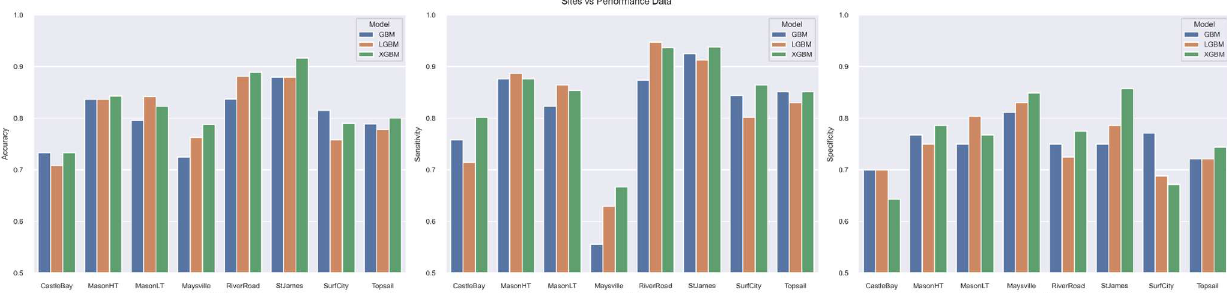
Figure 3. Performance metrics (Accuracy, Sensitivity, and Specificity in the order from left to right) of GBM, LGBM, and XGBM on each Individual Site.